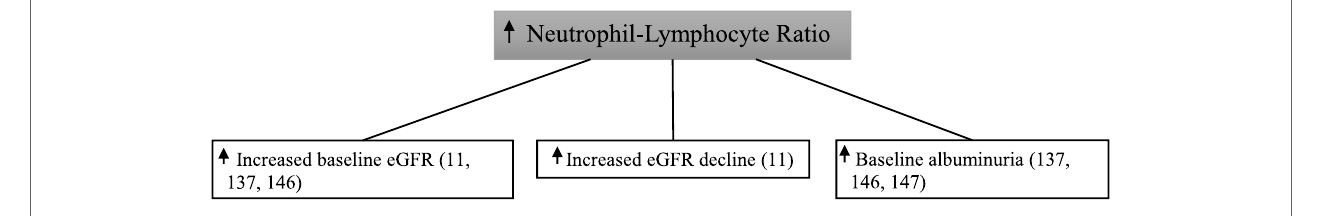
FiGURe 7 | Increased neutrophil–lymphocyte ratio and diabetic kidney